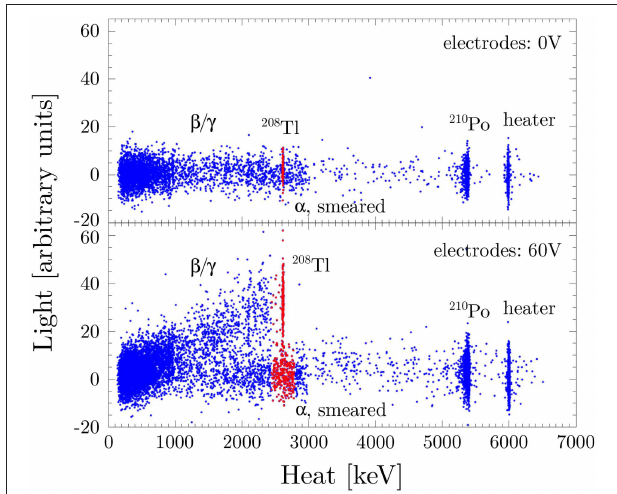
FIGURE 12 | Heat vs. light scatter plots obtained with a CUORE bolometer in coincidence with a NTL Ge light detector. (Top) The light detector is operated as a “standard” bolometric light detector, i.e., without applying any electrode voltage bias. (Bottom) The light detector working in a signal amplification regime, by applying 60V as electrode bias. This results in a clear separation between α and β/γ signals. Figure from Bergé et al. [ 111], with permission from the American Physical